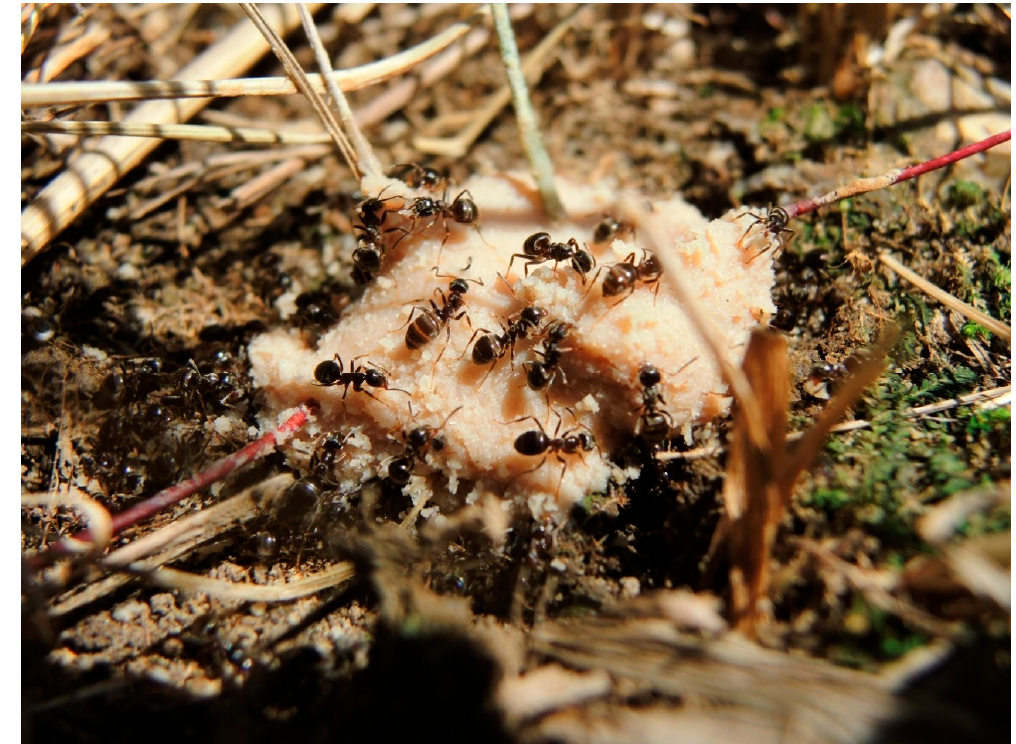
Figure 1. Workers of Lasius niger attracted to tuna bait (phot. M.O.).